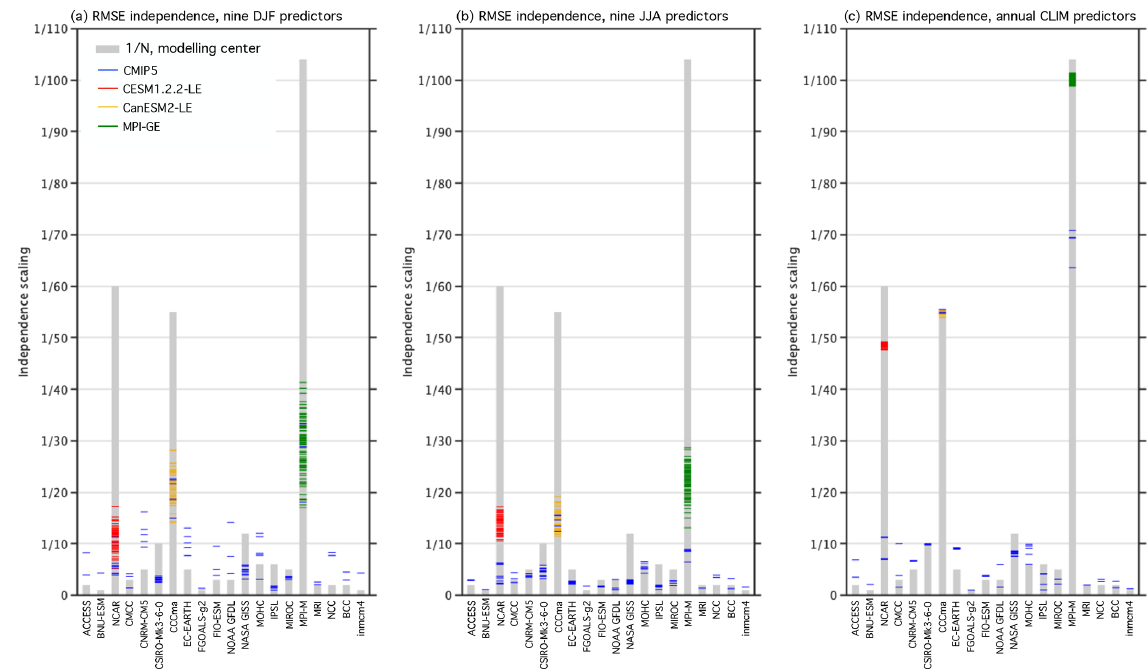
Figure 4. RMSE independence scalings (colored lines) of the SMILEs and CMIP5 ensemble members, grouped as listed in Table 1. CESM1.2.2-LE members are shown in red, CanESM2-LE members are shown in yellow, and MPI-GE members are shown in green, while the remainder of CMIP5 members are shown in blue. The 1 /N modeling center scaling is shown by gray bars behind each grouping as a point of reference. (a, b) The scalings computed from the nine predictors used in the original DJF and JJA RMSE distance weightings, respectively. (c) The scalings computed from global land SAT and Northern Hemisphere SLP climatology predictors.